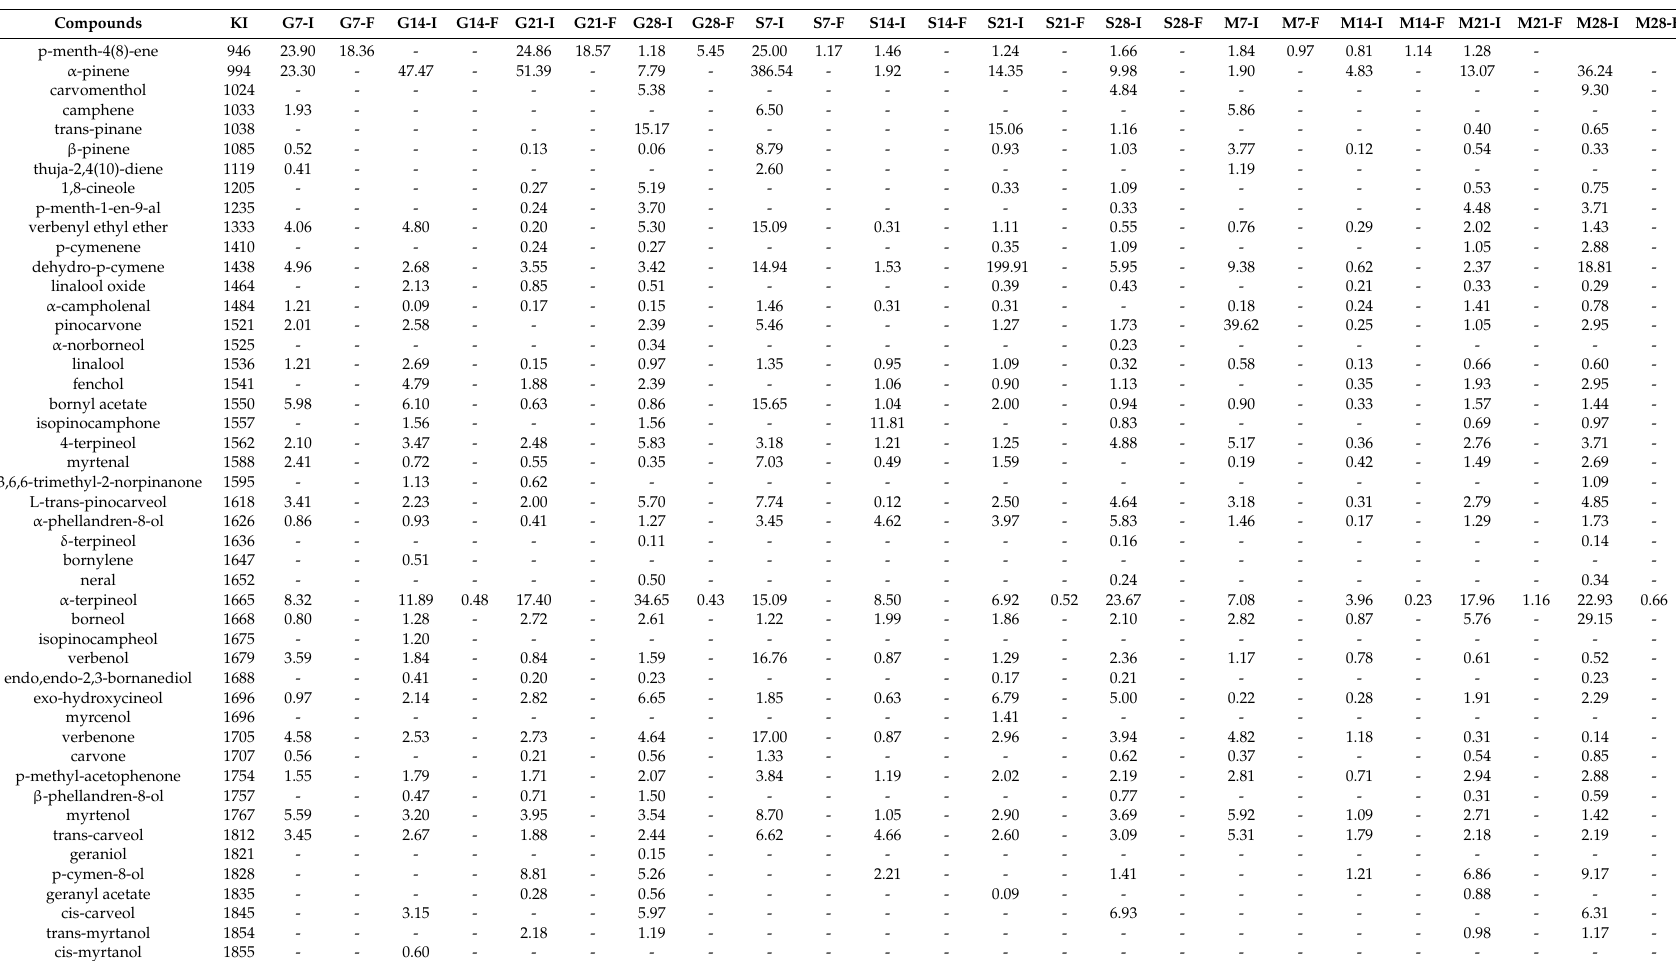
Table 4. Semi-quantification of terpenoids (mg L − 1 ) detected by SPME / GC-MS analysis in fermentation batches of synthetic mediums by free or immobilized S. cerevisiae AXAZ-1 cells on P. terebinthus resin at di ff erent temperatures.